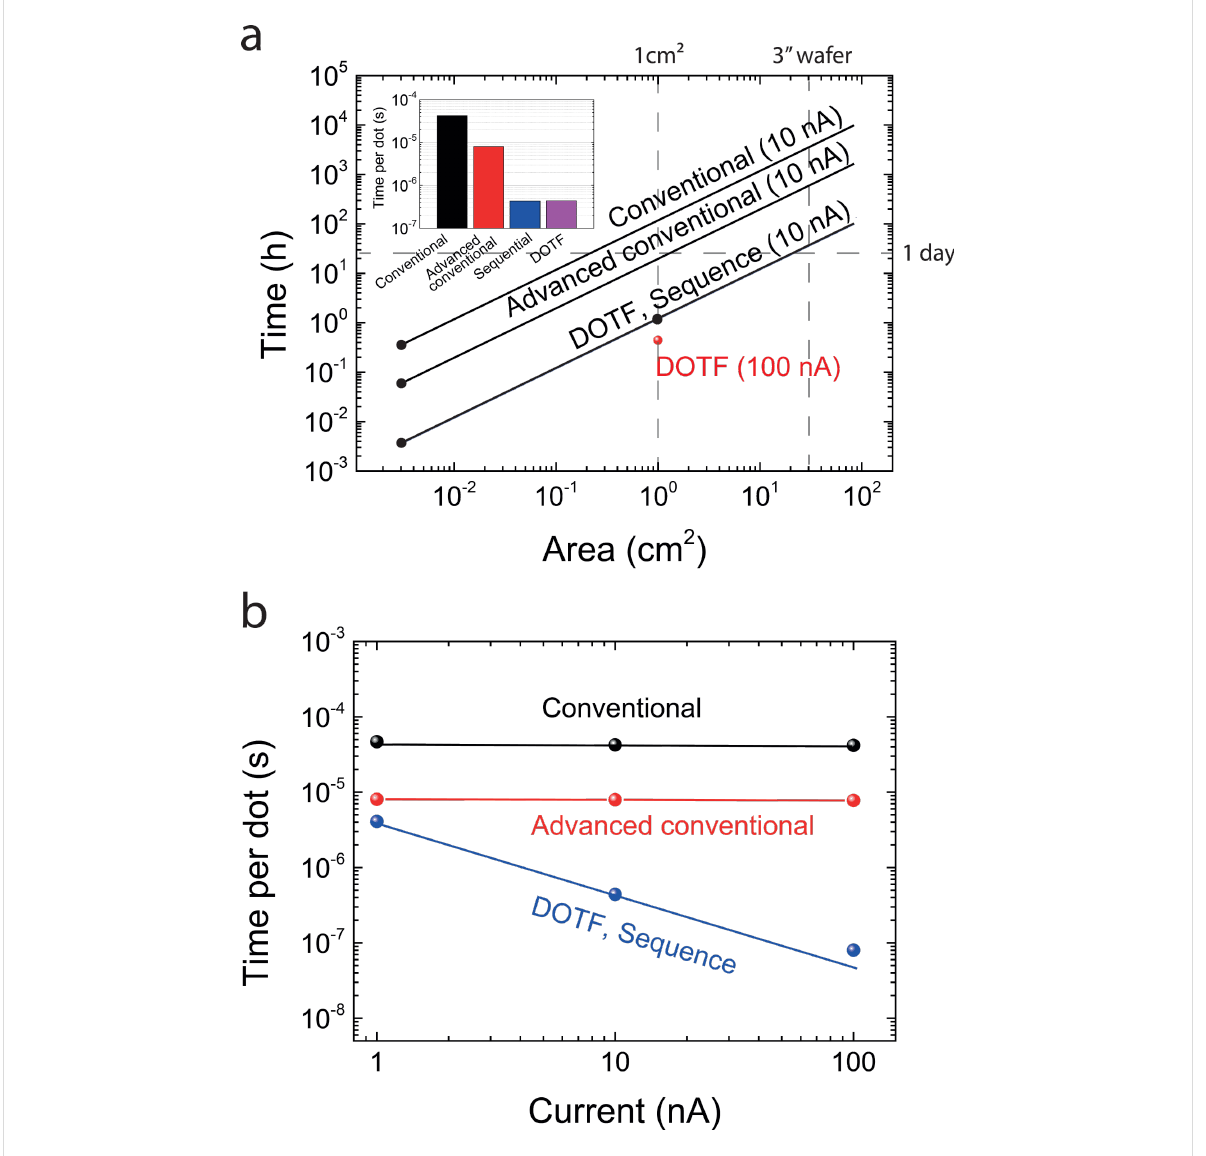
Figure 3: a) Plot of the estimated writing times per gold nanoarray area for each of the four different methods using an e-beam current of 10 nA and a pitch of 100 nm. Black points correspond to measured values. The writing time for DOTF technique with 100 nA is plotted for discussion. Inset: Equivalent writing time per dot for the four techniques. (b) Time per dot plotted as a function of the e-beam current for the four methods: ≈ 40 µs for the conventional method (limiting factor is the main field deflection) and ≈ 8 µs for the advanced conventional method (limiting factor is the pattern gener- ator overhead). There is almost no overhead with DOTF and “sequence” methods, so the time is linear with the exposure time (inversely proportional to the